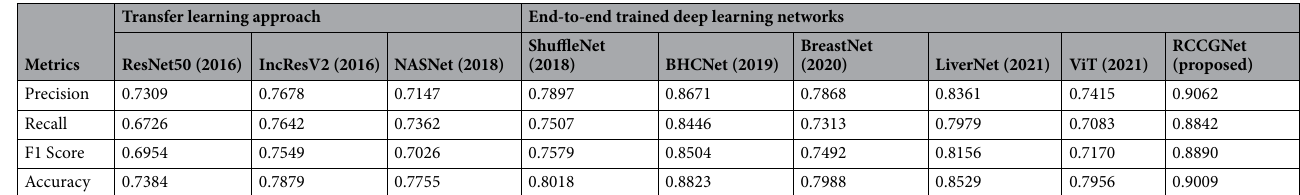
Table 5. Overall quality comparison of proposed model with other competitive model (BreakHis dataset- Eight